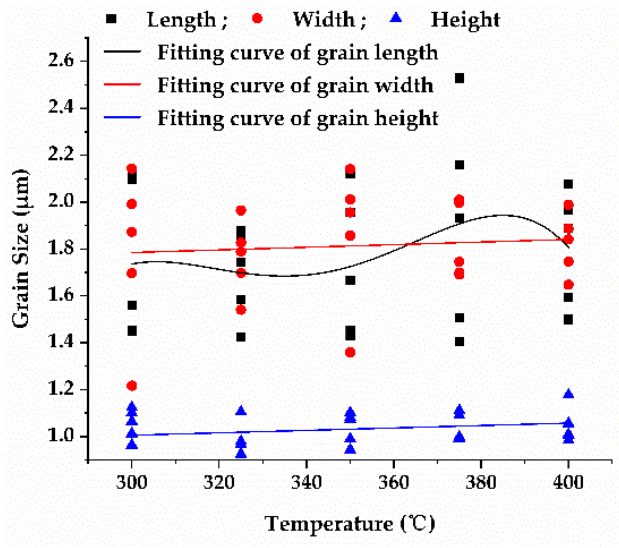
Figure 4. Effect of substrate temperature on active grain size.